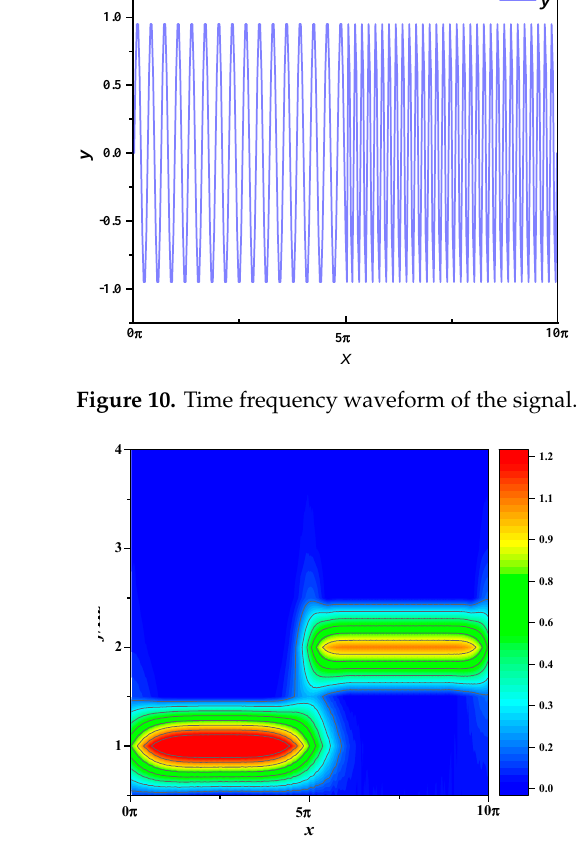
Figure 11. Spectrum based on Morlet wavelet.